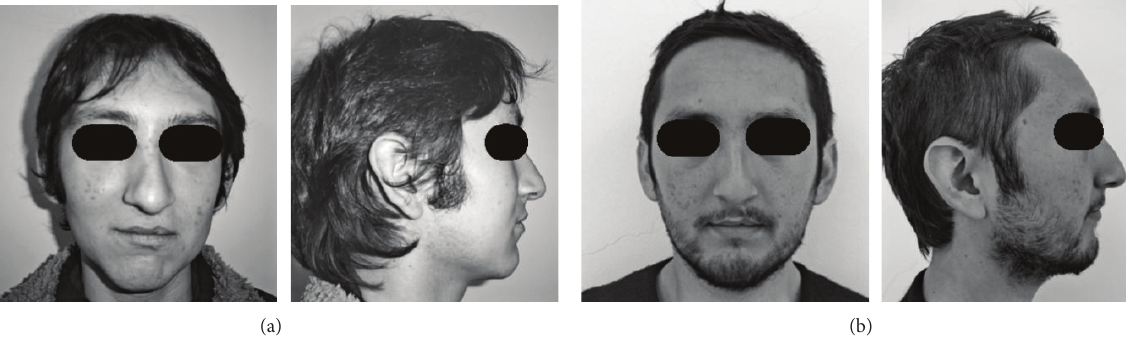
Figure 5: Extraoral images at the beginning (a) and at the end (b) of the treatment. No major changes were made after orthodontic treatment. The scar of the upper lip is slightly